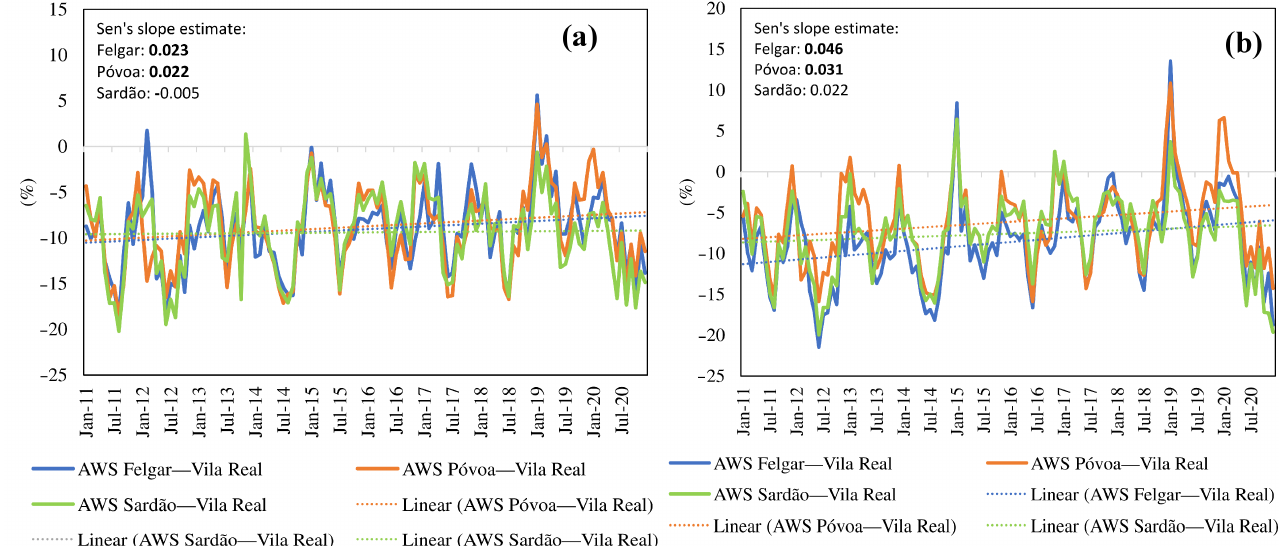
Figure 7. Monthly relative humidity anomalies trend between the AWS network stations and the Vila Real control station for the period 2011–2020: ( a ) mean relative humidity and, ( b ) minimum relative